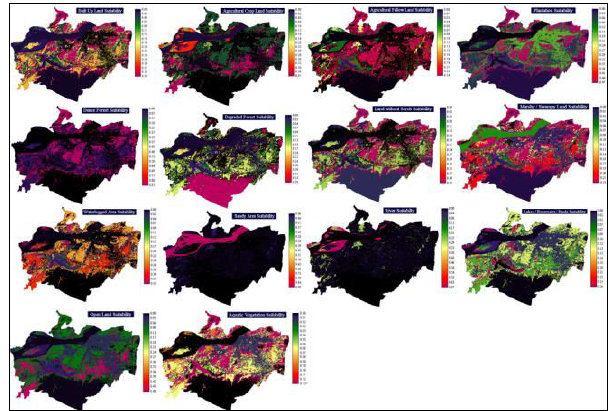
Figure 4. Suitability (evidence likelihood) map used to